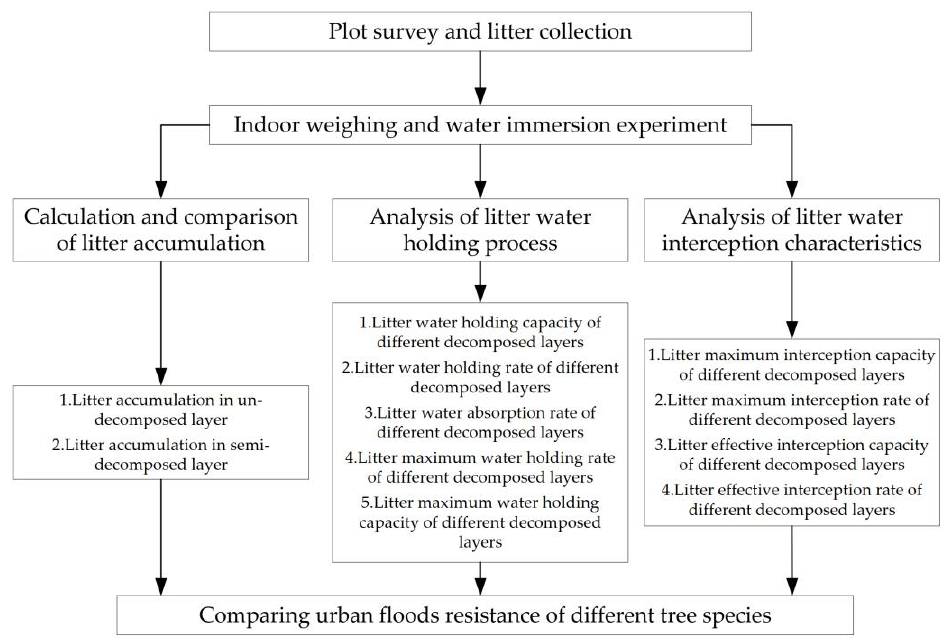
Figure 1. Flow chart of the methodology.